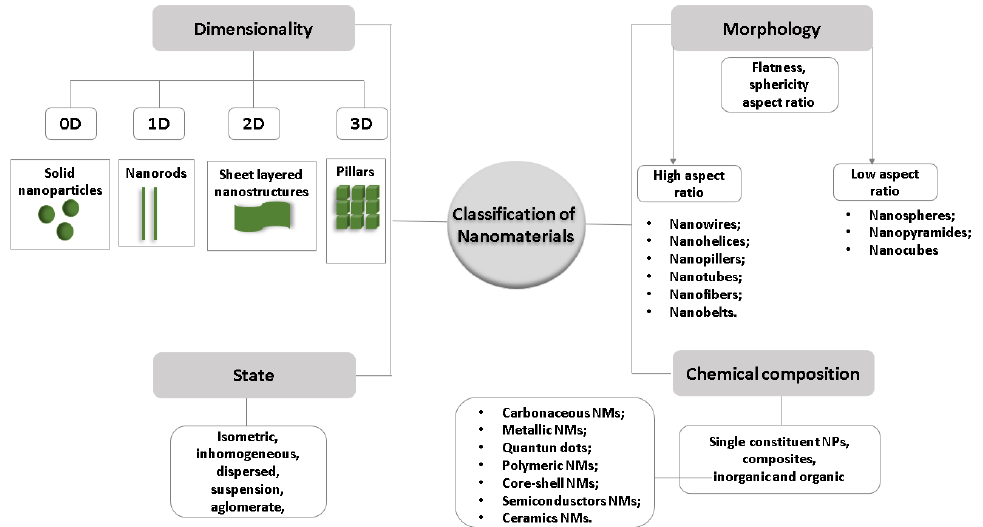
Figure 1. Schematic illustration of the classification of nanomaterials based on different criteria, Reprinted with permission from ref. [110]. Copyright 2021 Clearance Center .